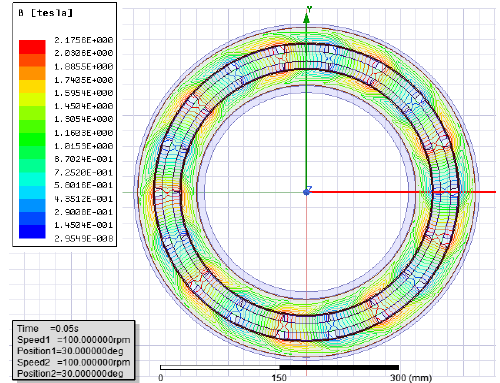
Figure 12. Cloud diagram of magnetic force line distribution.